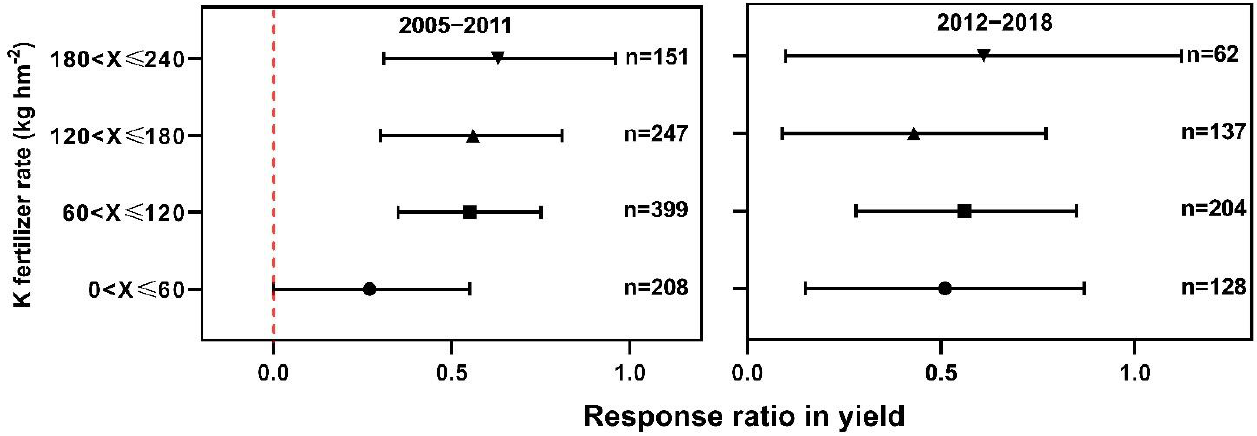
Figure 12. The effects of K fertilization levels on maize yield in different periods. The error lines indicate the 95th percentile bootstrap confidence intervals, while n values indicate the corresponding number of observations (total number of control and treatment values). Yield with K fertilization is a treatment value, while yield without K fertilization is a control value.